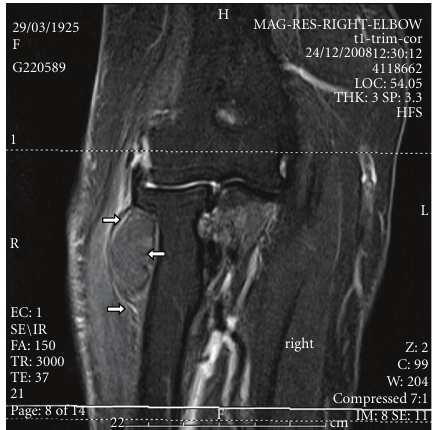
Figure 2: T1-weighted coronal MR image reveals the displacement exerted on surrounding structures by the lesion around the radius, white